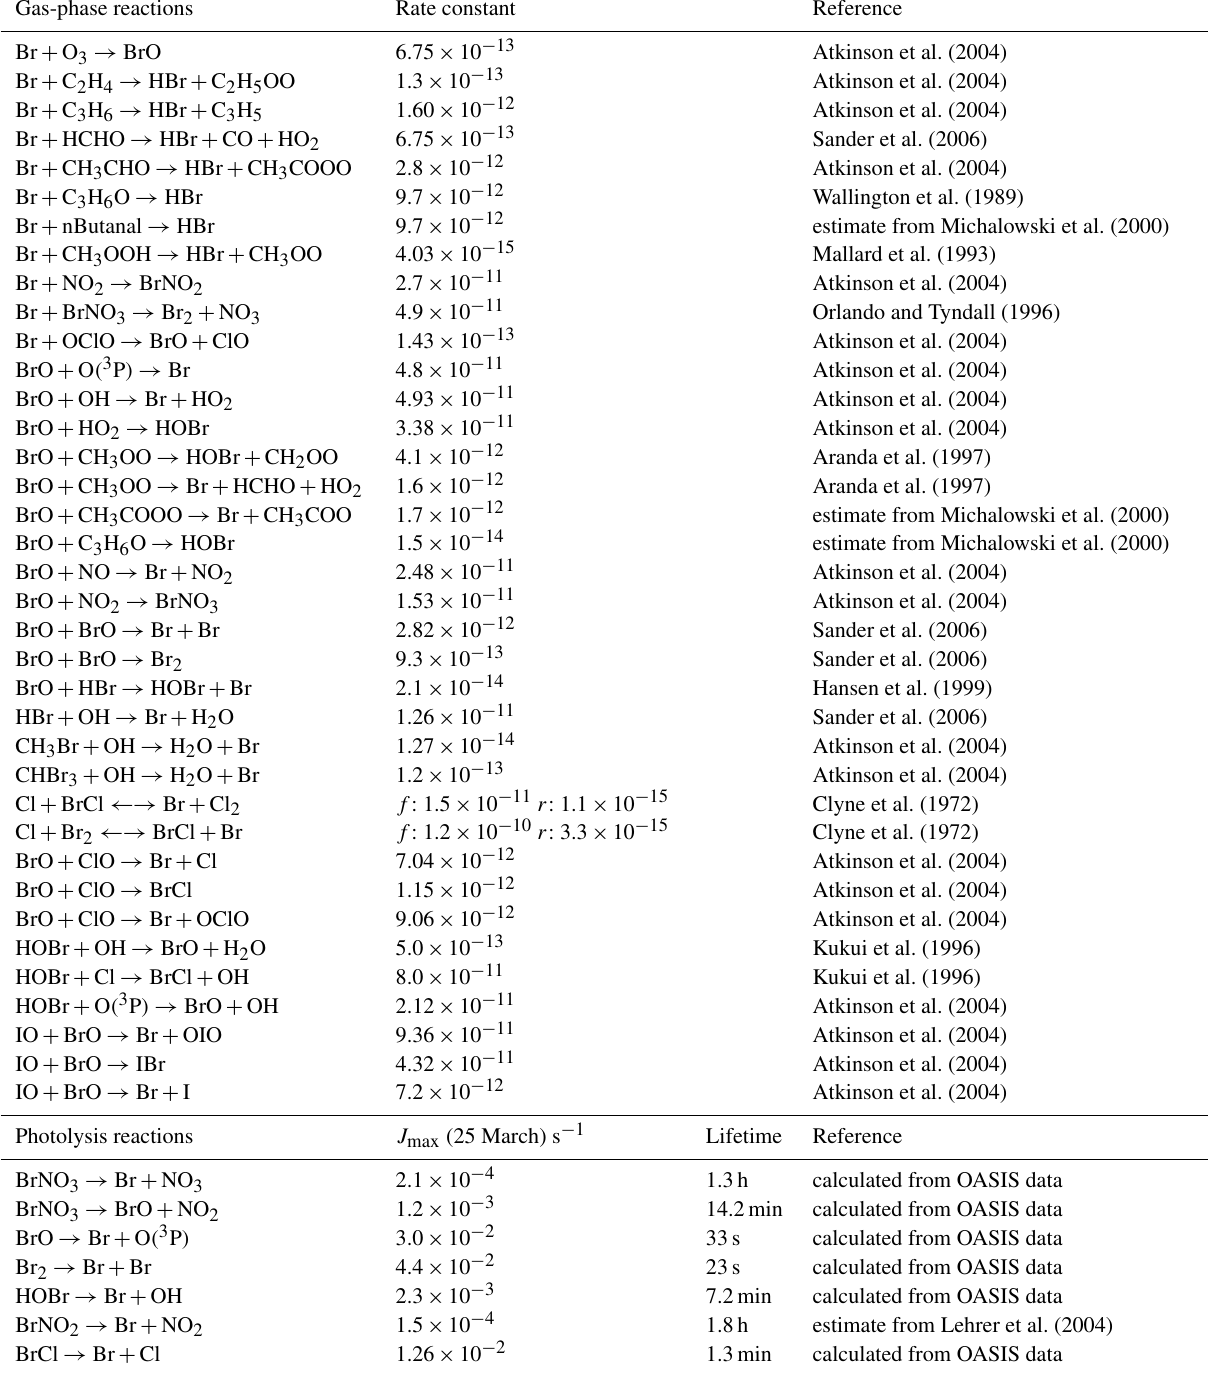
Table 1. Reactions used in the model that are pertinent to bromine chemistry. All rate constants (with the exception of photolysis J coeffi- cients) are in units of cm 3 molecule − 1 s − 1